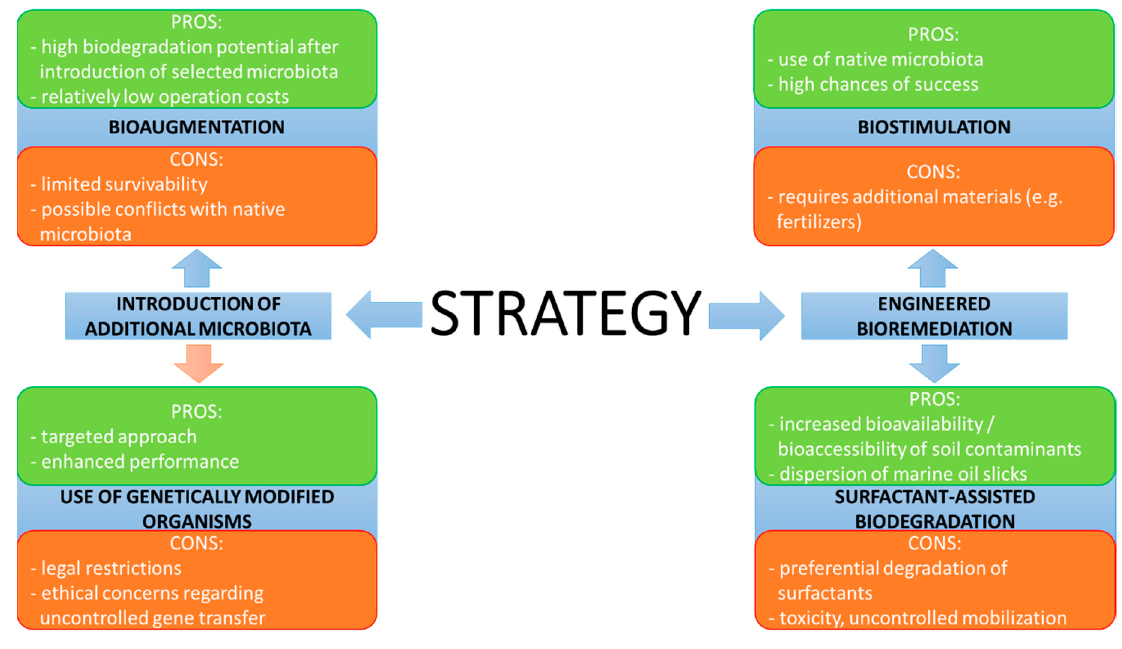
Figure 5. Overview of the most commonly applied strategies used to enhance hydrocarbon biodegradation processes for environmental